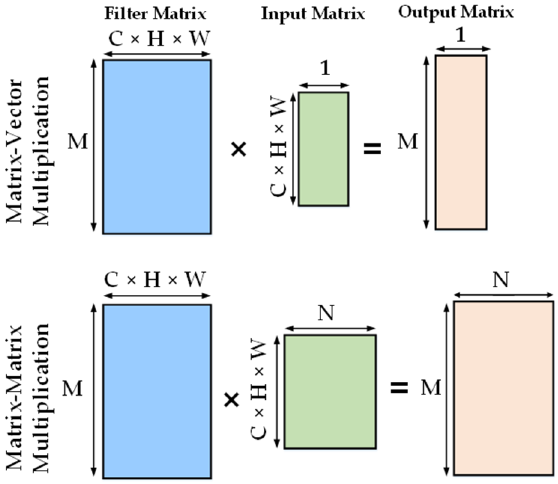
Figure 8. Single-instruction multiple-data (SIMD) operation.